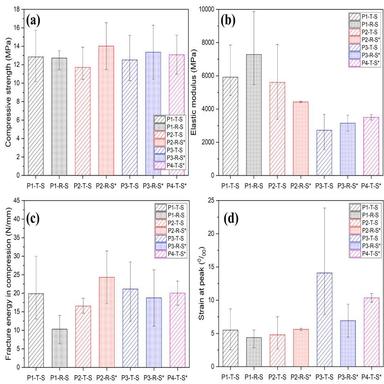
Mean values of compressive strength (a), elastic modulus (b), fracture energy in compression (c) and strain at peak, (d) for single-wythe cores extracted from P1 to P4.